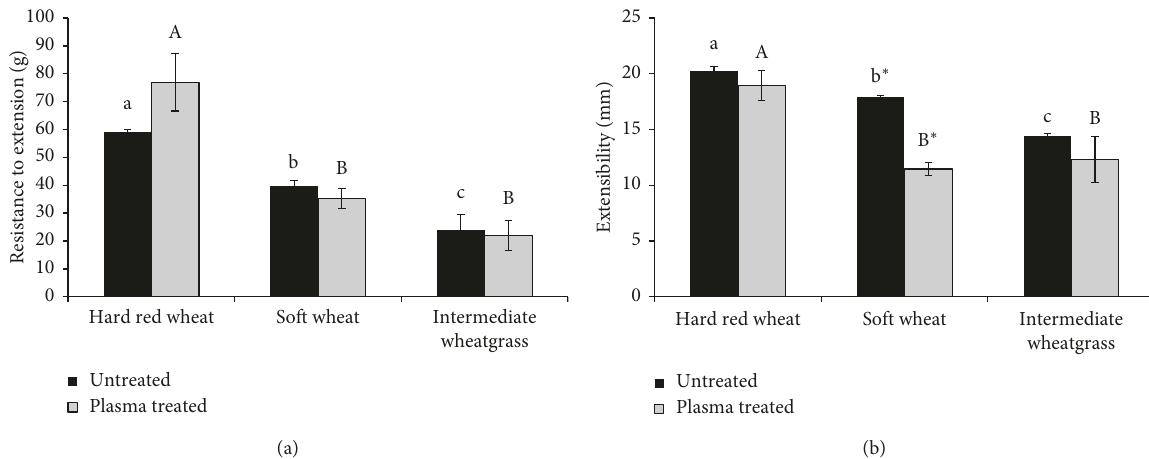
Figure 3: Extensibility and resistance to extension of dough ( n � 2) prepared from hard red wheat, soft wheat, and intermediate wheatgrass flour before and after plasma treatment.